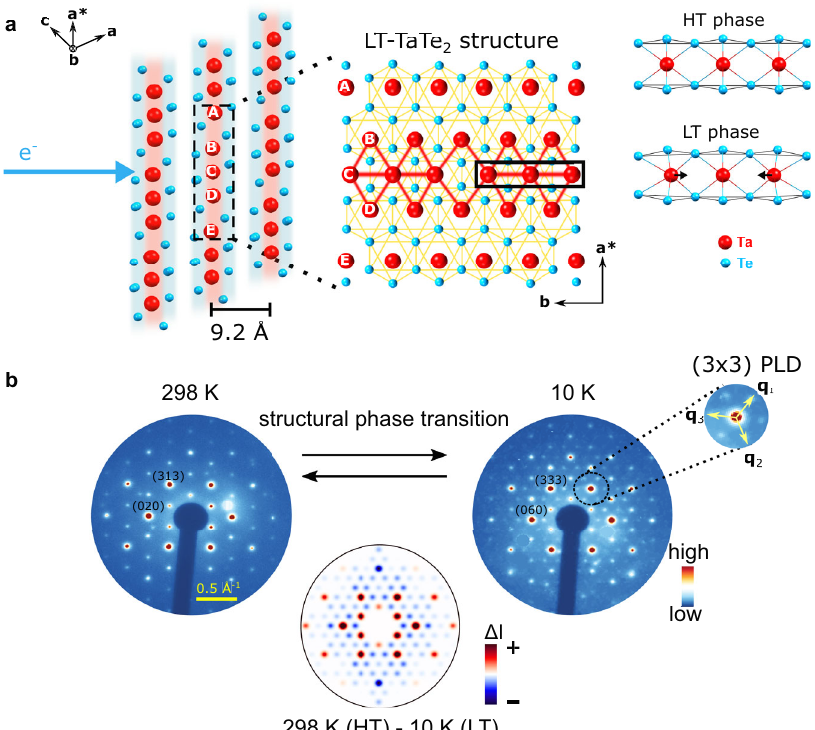
Fig. 1 Crystal structure and electron diffraction patterns at thermal equilibria. a Layered crystal structure of the low-temperature phase of 1T ′ -TaTe 2 . The electron beam is incident perpendicular to Ta and Te planes in the ultrafast electron diffraction (UED) experiments. The a, b, and c lattice vectors shown are those of the monoclinic unit cell. The projection perpendicular to the dashed region is indicated. Black box: Ta trimer clusters forming along the b -axis in the low-temperature (LT) phase. Representations of LT and high-temperature (HT) phases showing enhanced distortions in the LT phase are presented in the top right. Small black arrows denote the movement of atoms towards the central Ta atom. b Static electron diffraction patterns of 1T ′ -TaTe 2 obtained by 0.75 MeV electron pulses at 298 K (HT) and 10 K (LT) along the ½ (cid:1) 101 (cid:2) zone axis. Note the different indices for the LT pattern due to tripling along the b - axis. The inset shows the (3 × 3) periodic lattice distortion satellite (superlattice) peaks that arise in the LT phase. A few additional peaks are present due to diffraction from the Si support frame (see Supplementary Note 2 for sample details). The symmetrised difference pattern between HT and LT phases is shown below the static patterns, with contributions from the Si frame and silicon nitride (Si 3 N 4 ) membrane removed. The colour scale gives the absolute diffracted intensity change ( Δ I